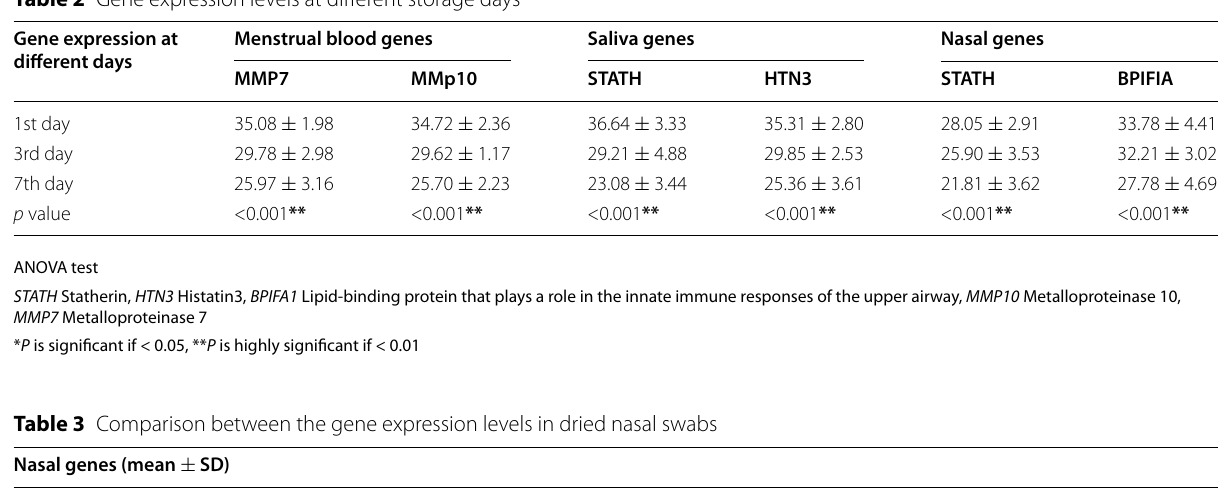
Table 3 Comparison between the gene expression levels in dried nasal swabs